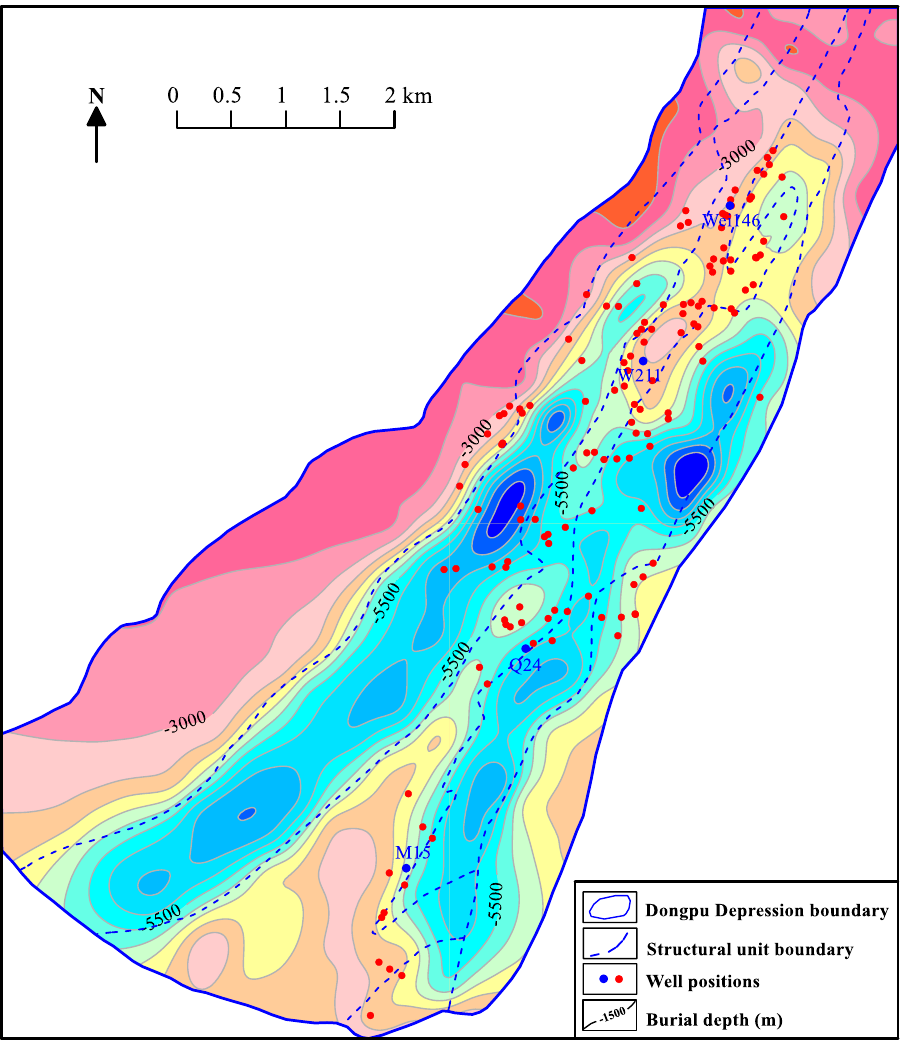
Figure 4. The bottom burial depth of the Cenozoic strata in the Dongpu Depression. Figure was produced by Surfer 15 (https:// www. golde nsoft ware. com/ produ cts/ surfer/).